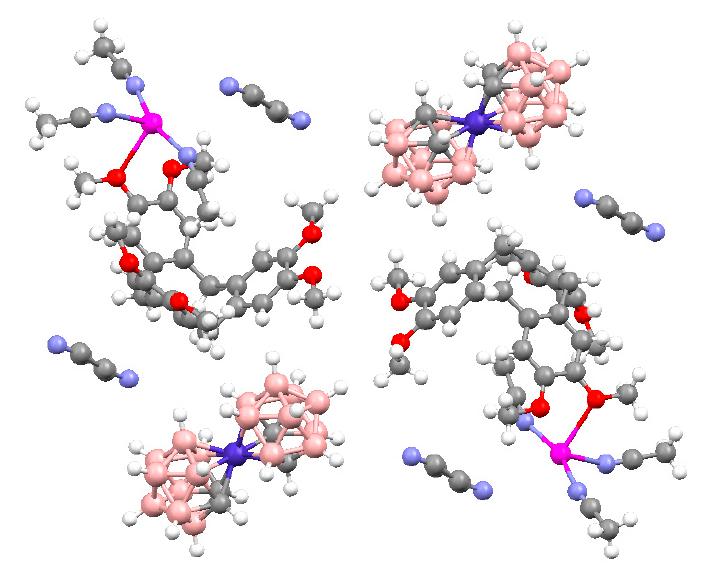
Figure 114. X-ray structure of [Ag(MeCN) 3 (CTV)][3,3’-Co(1,2-C 2 B 9 H 11 ) 2 ]·0.5MeCN.